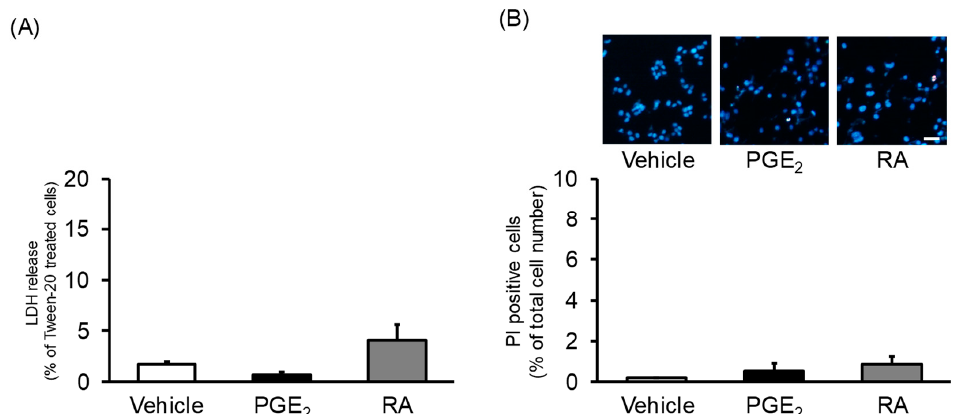
Figure 2. The effects of PGE 2 and RA on viability. Undifferentiated NSC-34 cells were treated with a vehicle (EtOH), 30 μ M PGE 2 for 2 days, or 10 μ M RA for 7 days. ( A ) Graph shows the percentage of released LDH of PGE 2 - and RA-treated cells relative to that of Tween-20-treated cells. Each value represents the mean ± SEM ( n = 4). ( B ) Photographs show representative fluorescence microscopy images of typical Hoechst 33,258/propidium iodide (PI) double staining in each treatment group. Scale bar indicates 50 μ m. Graph shows quantitative analysis of PI-positive cells, expressed as the ratio of PI-positive cells to Hoechst 33,258-positive cells. Each value represents the mean ± SEM ( n = 4).